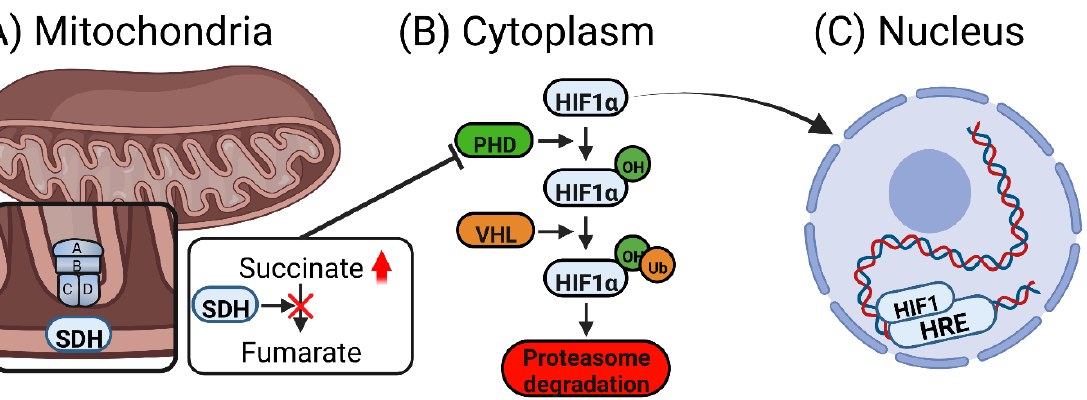
Figure 4. Succinate stabilizes HIF1 α by inhibiting its degradation. Succinate inhibits PHD leading to HIF1 α stabilization and translocation to the nucleus. Subsequently, assembly of the HIF1 complex occurs and induction of hypoxic responses takes place. Red arrow denotes increased succinate concentration. HIF: hypoxia-inducible factor, PHD: prolyl hydroxylase, VHL: von Hippel – Lindau protein, Ub: ubiquitin protein, HRE: hypoxia response element.